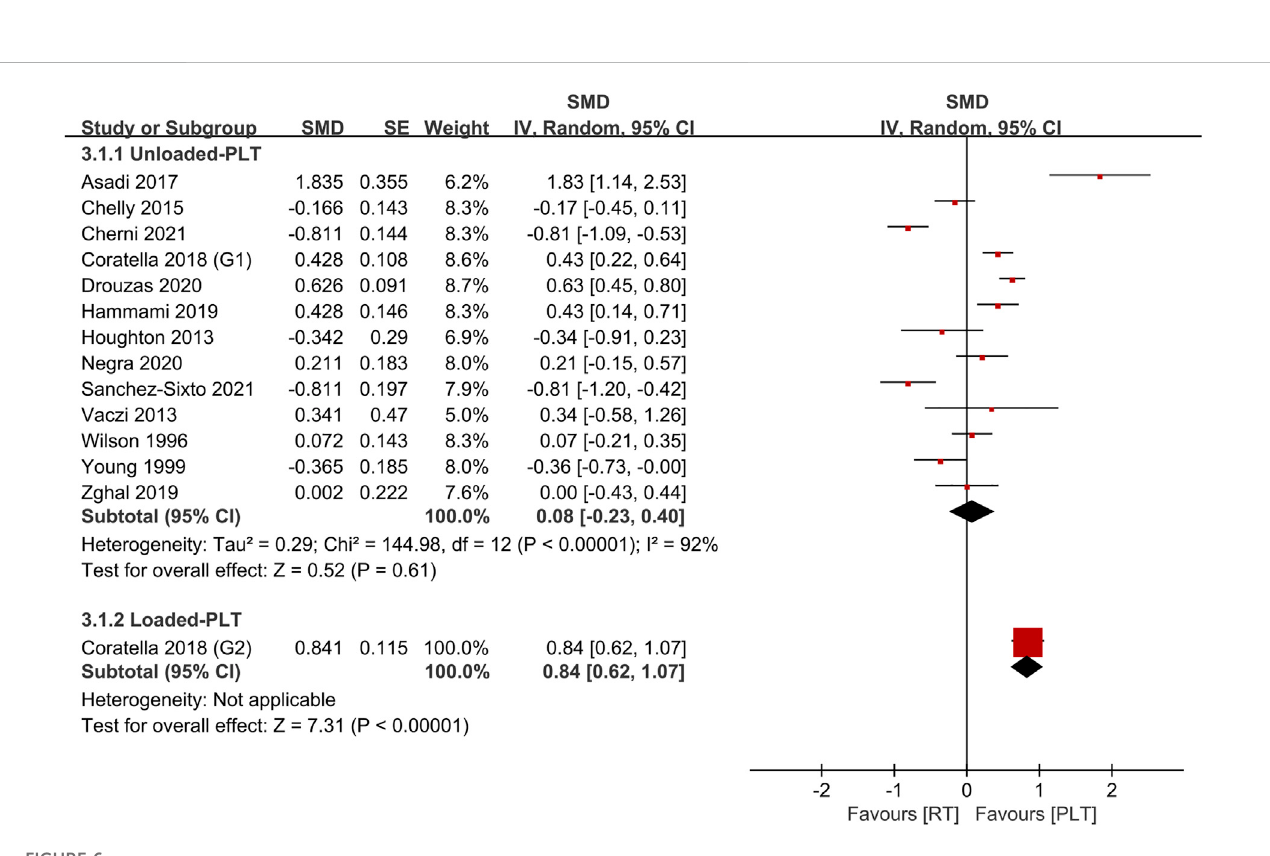
FIGURE 6 Effects of plyometric training (PLT) on maximum